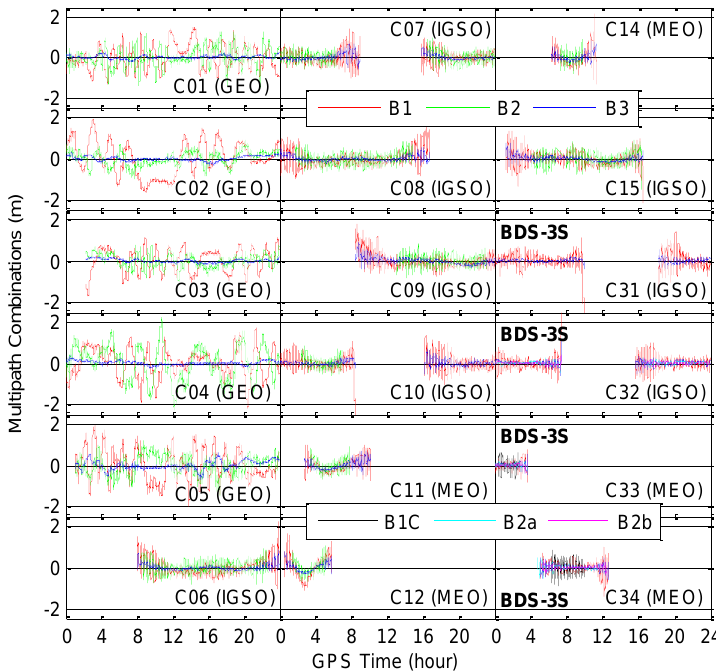
Figure 7. MP combination time series at station SGG1 on 13 July 2016. The red, green and blue lines refer to the MP combination time series for the code observations on the B1, B2 and B3 frequencies, while the black, cyan and magenta lines refer to the corresponding series for the three new navigation signals, namely B1C, B2a and B2b.